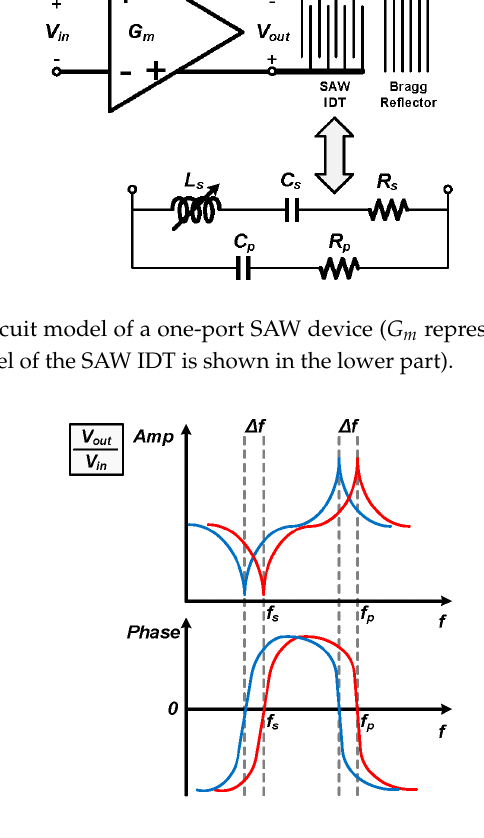
Figure 1. Equivalent circuit model of a one-port SAW device ( G m represents the input driver of the SAW IDT, the RLC model of the SAW IDT is shown in the lower part).